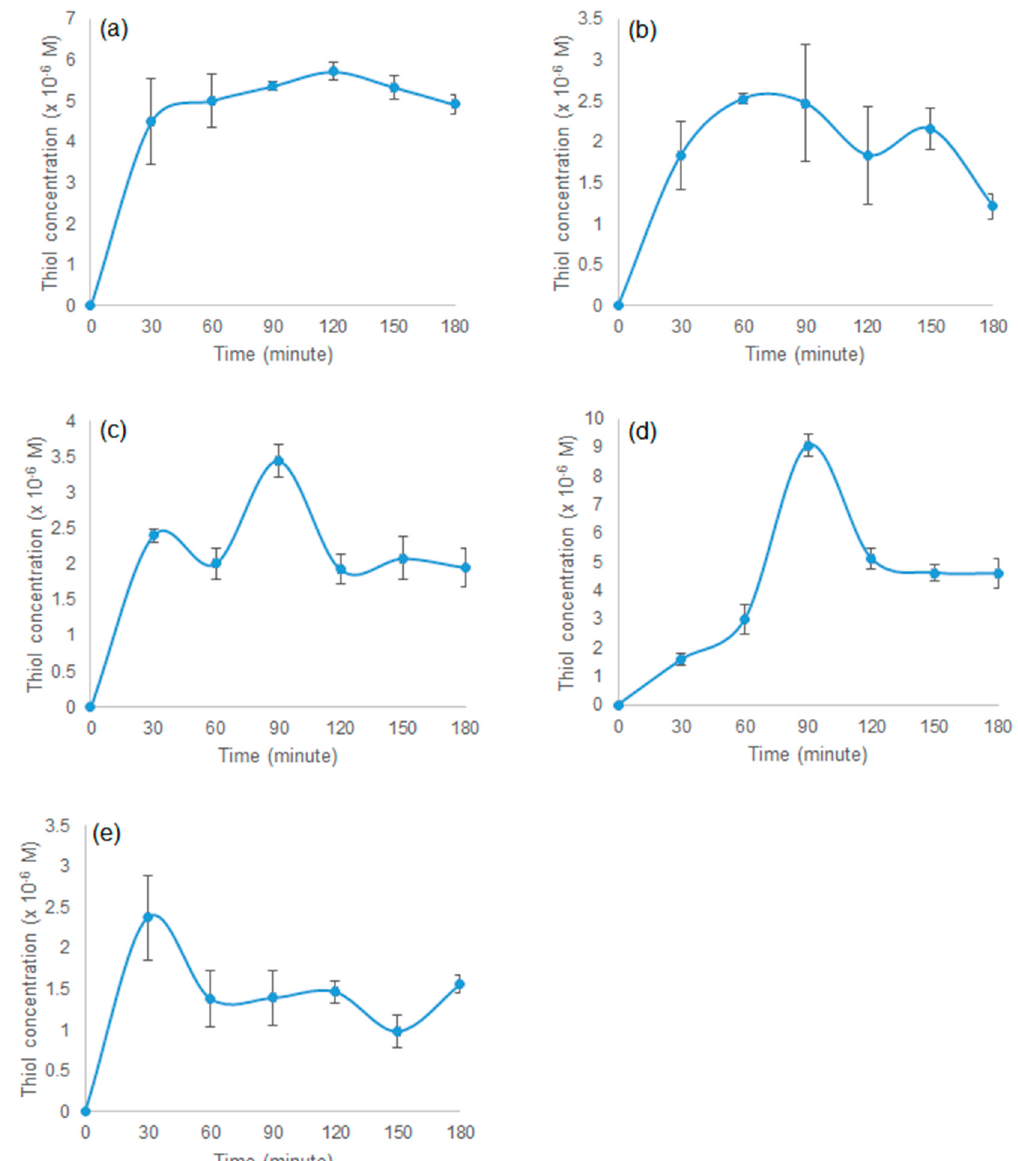
Figure 6. Chemical reduction of polymer ( a ) P10, ( b ) P15, ( c ) P21, ( d ) P25, and ( e ) P51, mean ± SEM, n =